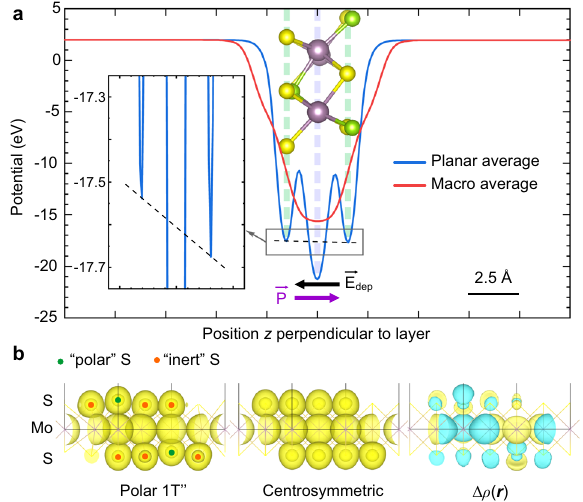
Fig. 2 First-principles simulations of internal potential and polarization for a 1T ” -MoS 2 monolayer. a The calculated potential is a three-dimensional function. The “ planar-average ” potential is calculated as a function of z (i.e., in the direction perpendicular to the S-Mo-S layer) by averaging in z -planes. The three potential wells of the planar-average potential coincide with the planes containing the S and Mo atoms (see the atomic structure in inset with atoms colored as in Fig. 1d). The macroscopic-average potential, commonly used to identify the depolarizing fi elds, is calculated by averaging the planar-average potential over a 3 Å-wide trailing window. It is found that the depolarizing fi eld here cannot be clearly observed in this way as the trailing window is comparable with the total width of the layer. Nevertheless, the planar-average potential does show that the potential well associated with the S atoms to the right of the Mo plane is slightly deeper than the well associated with the S atoms to the left (see zoom-in inset), which is indicative of a depolarizing fi eld pointing to the left and, thus, an electric dipole pointing to the right. b Side view of the 1T ” -MoS 2 monolayer, showing the computed electronic charge density for the polar state (left panel) and a reference centrosymmetric structure obtained by removing the polar distortion from the polar one (center panel). The fi nal fi gure (right panel) shows a charge density difference, where cyan lobes indicate an excess of electrons in the polar state. In the left image, the charged density of “ polar ” and seemingly “ inert ” sulfur atoms are labeled by green and orange dots,